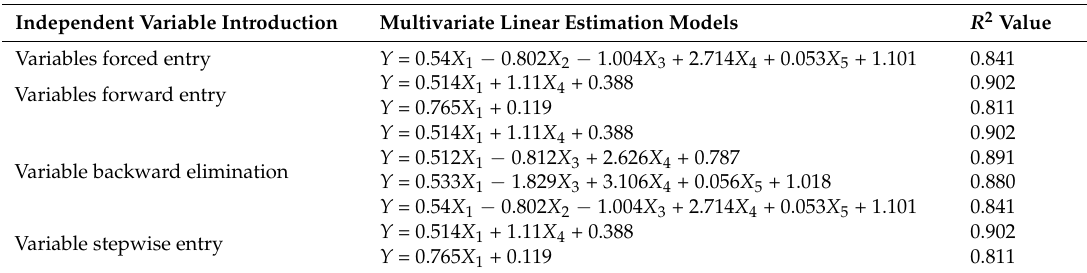
Table 4. Multivariate linear estimation models of S. alterniflora